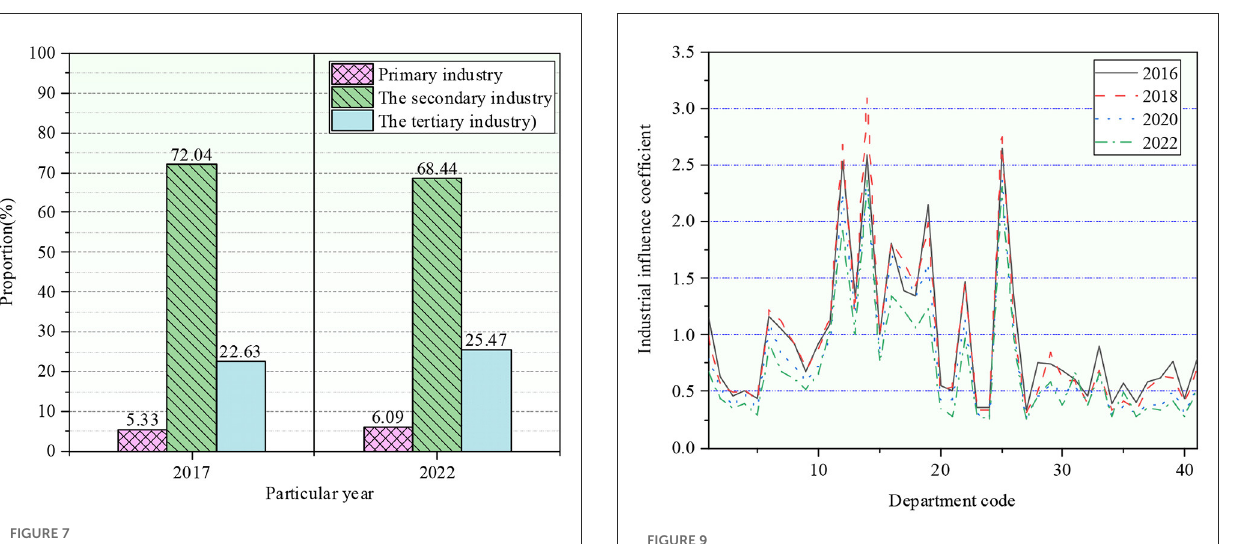
FIGURE9 The industrial influence coefficient during 2016–2022.